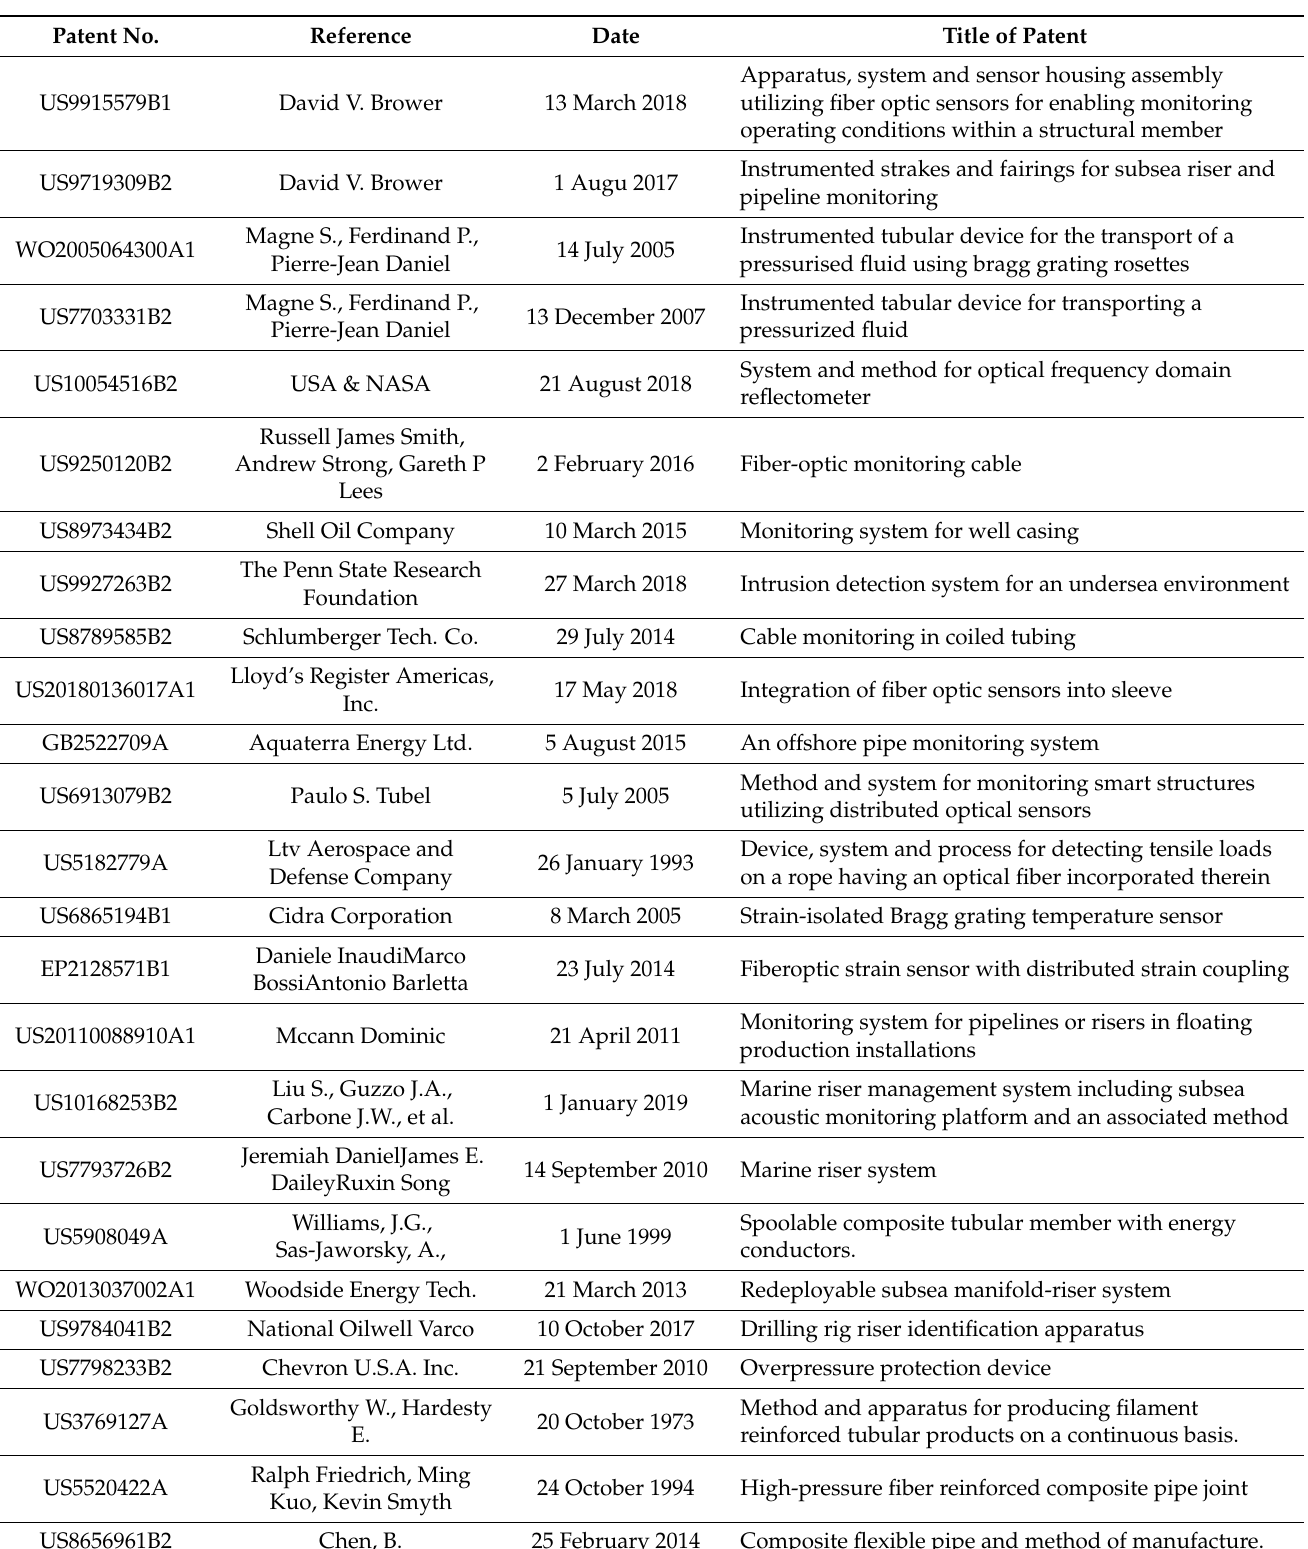
Table 5. Patent list on monitoring devices with methods for composite risers, marine hoses, and flexible